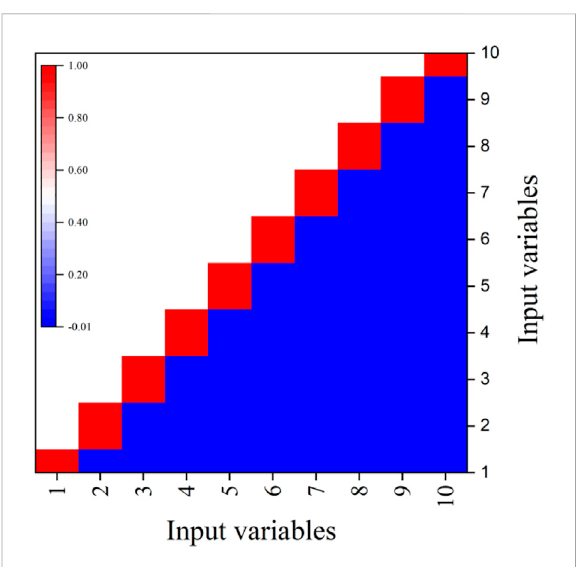
FIGURE 3 Independence among 10 variables after PCA